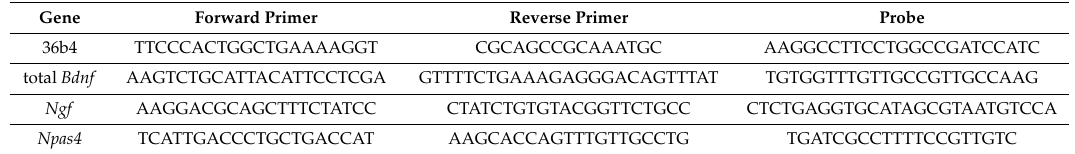
Table 2. Forward, reverse and probe sequences.